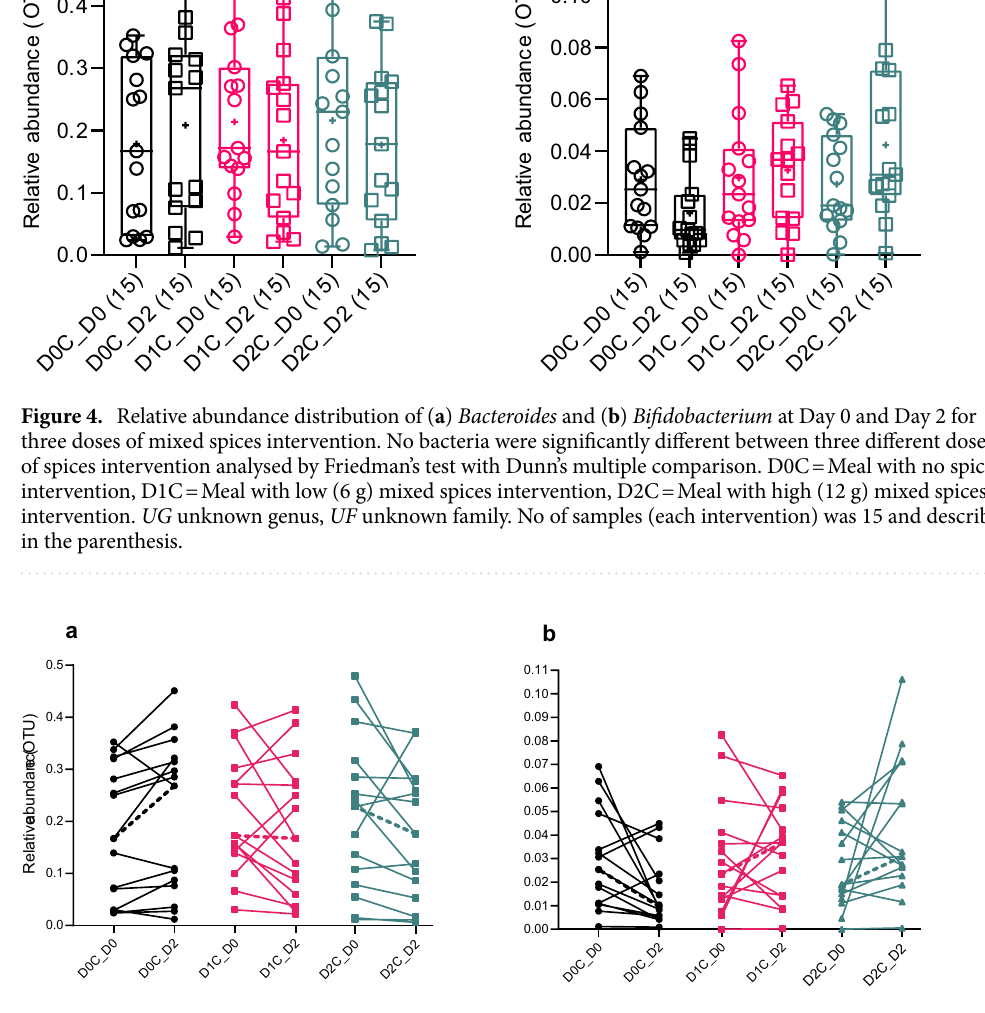
Figure 5. Paired individual changes in relative abundance between two time points (Day 0 to Day 2) for three spices doses ( a ) Bacteroides and ( b ) Bifidobacterium . Wilcoxon matched-pairs signed rank test was applied and significant pairs were described as * p < 0.05. D0C = Meal with no spices intervention, D1C = Meal with low (6 g) mixed spices intervention, D2C = Meal with high (12 g) mixed spices intervention. n = 15 each intervention. Dashed line indicates median